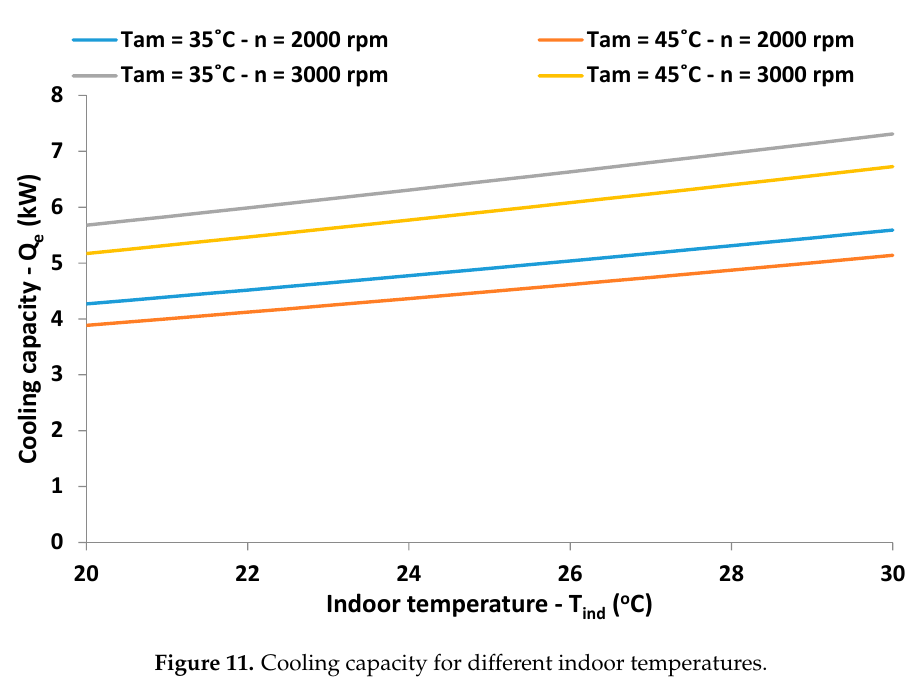
Figure 10. Coefficient of performance for different indoor temperatures.